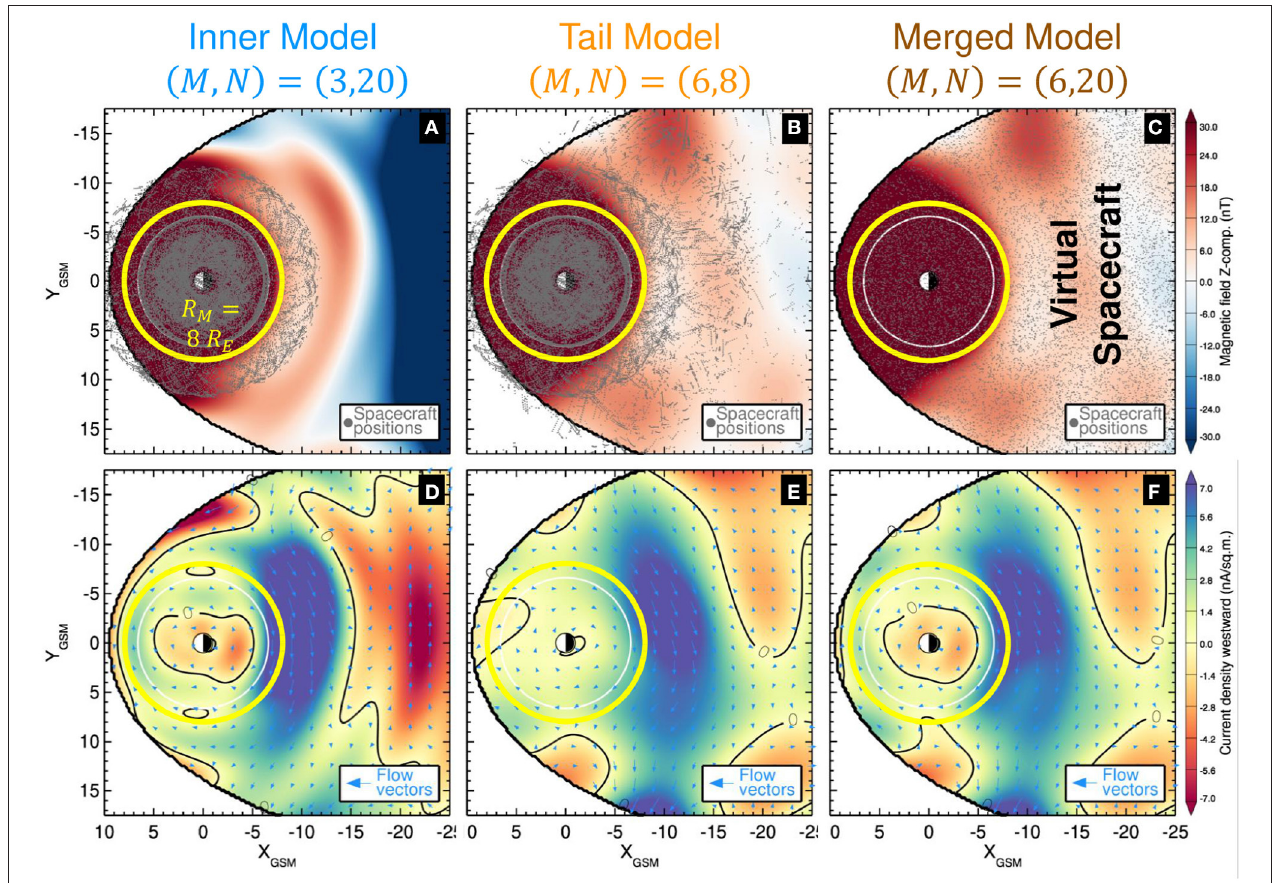
FIGURE 4 | The Merged Model . 2D equatorial distributions of the late growth phase (11:25) of a substorm on 8 March 2009 using the merged equatorial resolution model compared to the Inner and Tail models. (A–C) The equatorial distribution of the total modeled magnetic field. The location of the spacecraft magnetic field observations (virtual for the Merged Model ) used to fit the model are overplotted with gray dots. The merging radius R M (D–F) The equatorial distribution of the current density. The overplotted arrows show the direction and magnitude of the current density vectors. Note how the Merged Model resembles the Inner/Tail models inside/outside R M